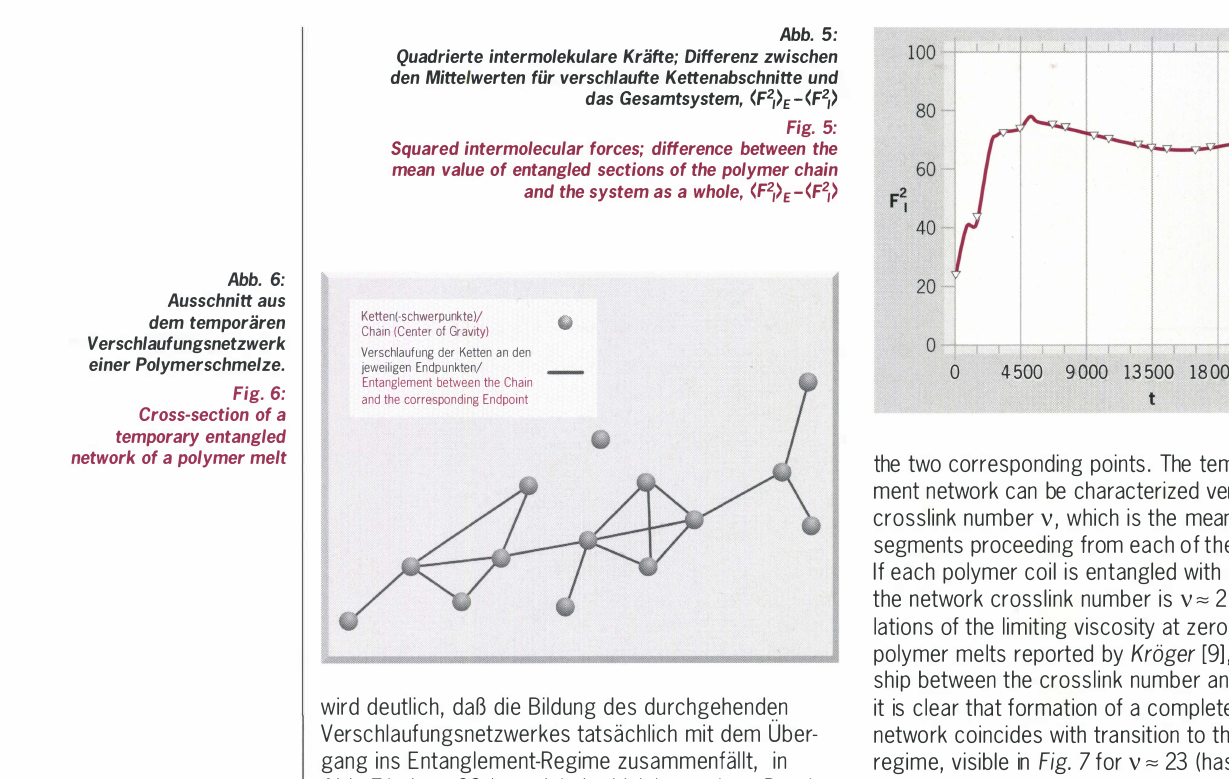
Abb. 7: Auftragung von